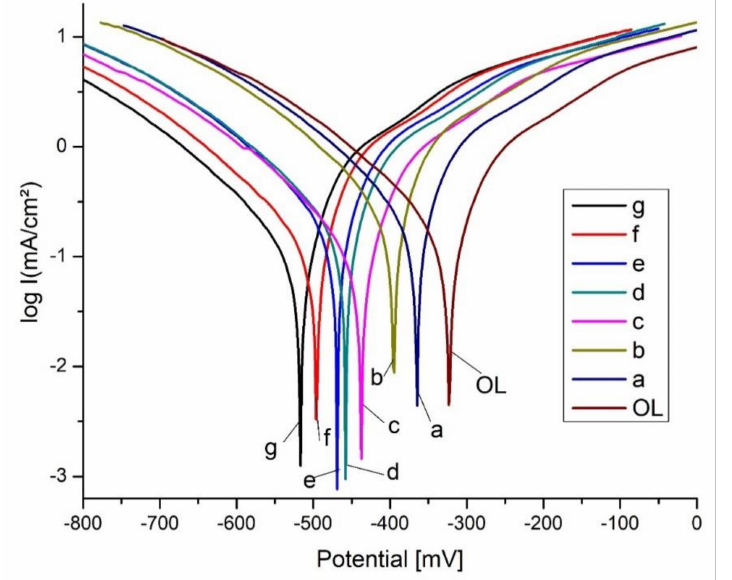
Figure 5. Tafel polarization curves recorded in 0.1 M HCl for the studied electrodes: OL (bare electrode); ( a ) MnTa 2 O 6 ; ( b ) 5,10-(4-carboxy-phenyl)-15,20-(4-phenoxy-phenyl)- porphyrin; ( c ) 5,15-(4-carboxy-phenyl)-10,20-bis-phenylporphyrin; ( d ) MnTa 2 O 6/ 5,10-(4-carboxy- phenyl)-15,20-(4-phenoxy-phenyl)-porphyrin; ( e ) 5,10-(4-carboxy-phenyl)-15,20-(4-phenoxy-phenyl)- porphyrin/MnTa 2 O 6 ; ( f ) MnTa 2 O 6 /5,15-(4-carboxy-phenyl)-10,20-bis-phenylporphyrin; ( g ) 5,15-(4- carboxy-phenyl)-10,20-bis-phenylporphyrin/MnTa 2 O 6